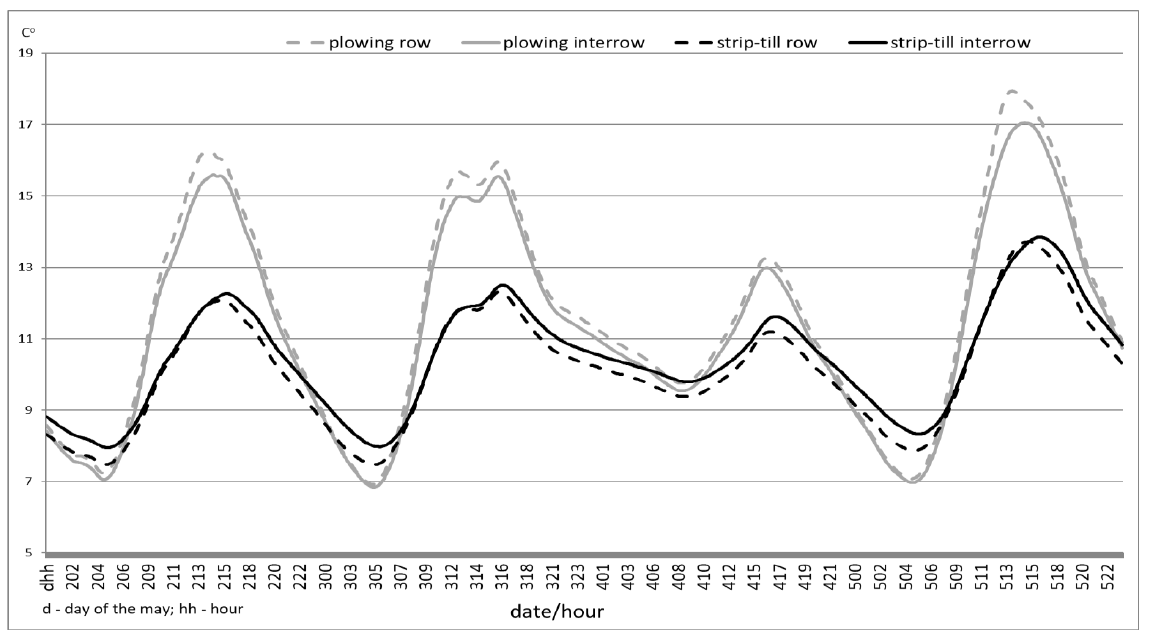
Figure 7. Soil temperature dynamics depending on the tillage technology (ST vs. PT) in the row and between the rows in the period 2 – 5 May.